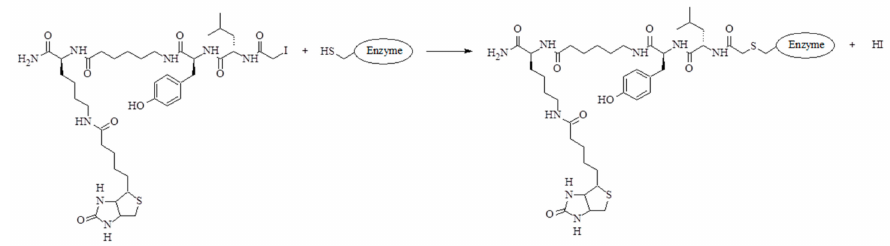
Figure 8. Diagram presenting the mechanism of binding of a biotinylated inhibitor to the active site of cysteine